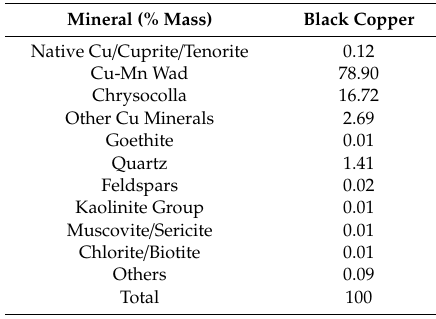
Table 1. Mineralogical composition of the black copper